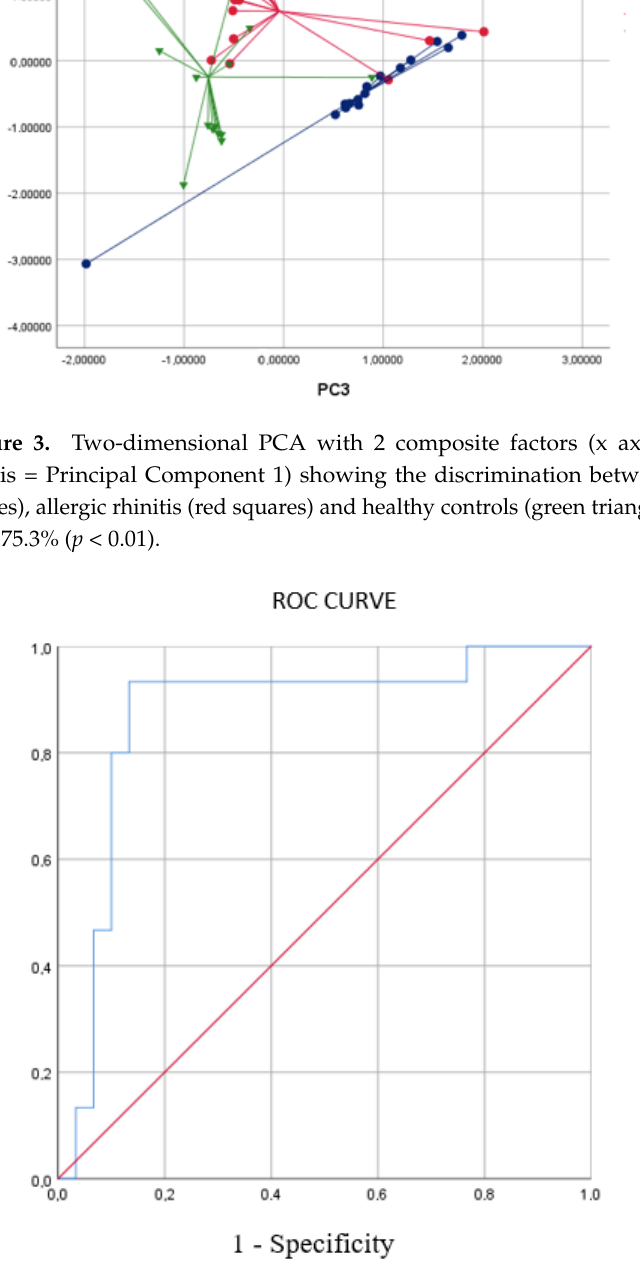
Figure 4. ROC-curve with line of identity of the breathprint discriminant function (representing PC1 and PC3), predictive for the discrimination of HNC from allergic rhinitis and healthy controls. AUC was 0.871 (95% CI: 0.749–0.994). Blue line = ROC-curve; Red line = random classifier.